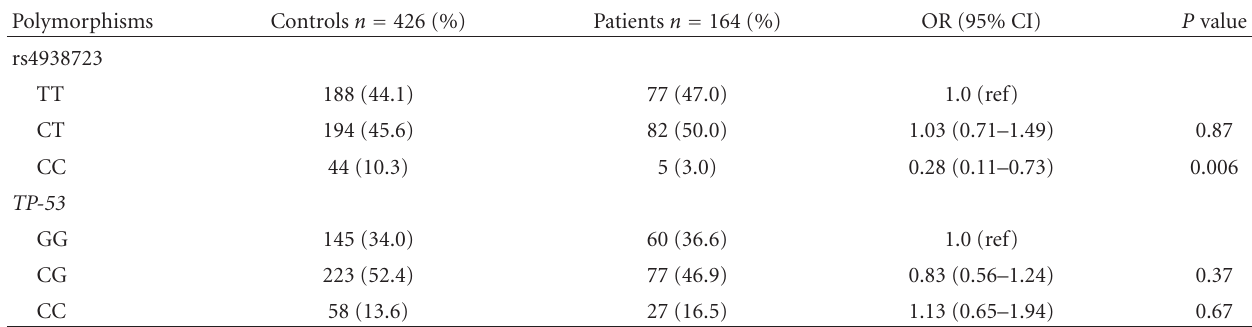
Table 2: Genotype frequencies of miR-34 rs4938723 and TP-53 Arg72Pro between patients with intracranial aneurysm and controls. Polymorphisms